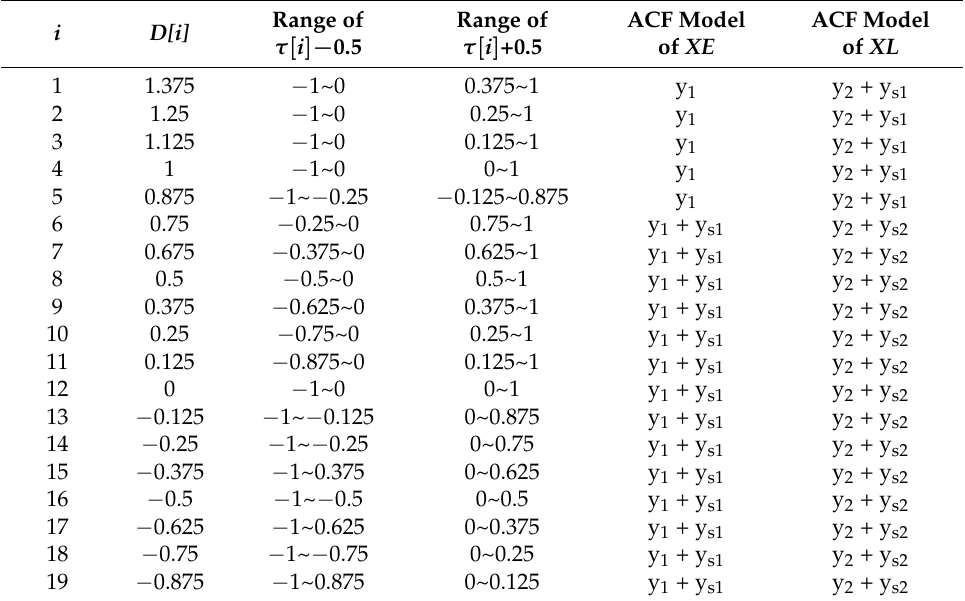
Table 4. Range of τ [ i ] and ACF model of XE and XL according to the D[i] .